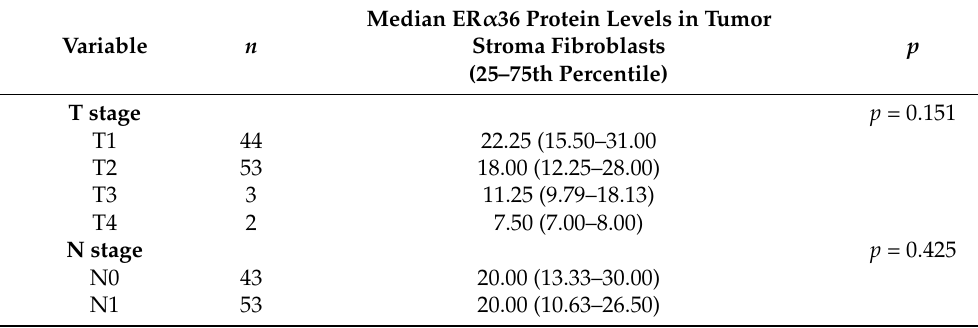
Table 1. Analysis of ER α 36 protein levels in tumor stromal fibroblasts in the context of clinicopatho- logical data. Mann–Whitney U test was used in the analysis of two samples, the Kruskal–Wallis test was used in the analysis of three and more